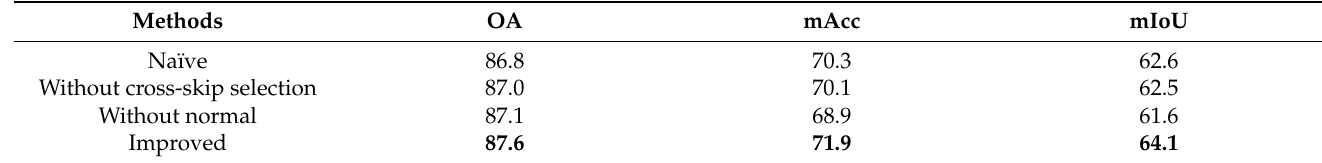
Table 5. Segmentation results on area 5 of S3DIS. (Naïve: naïve local transformer; Improved: im- proved local transformer).